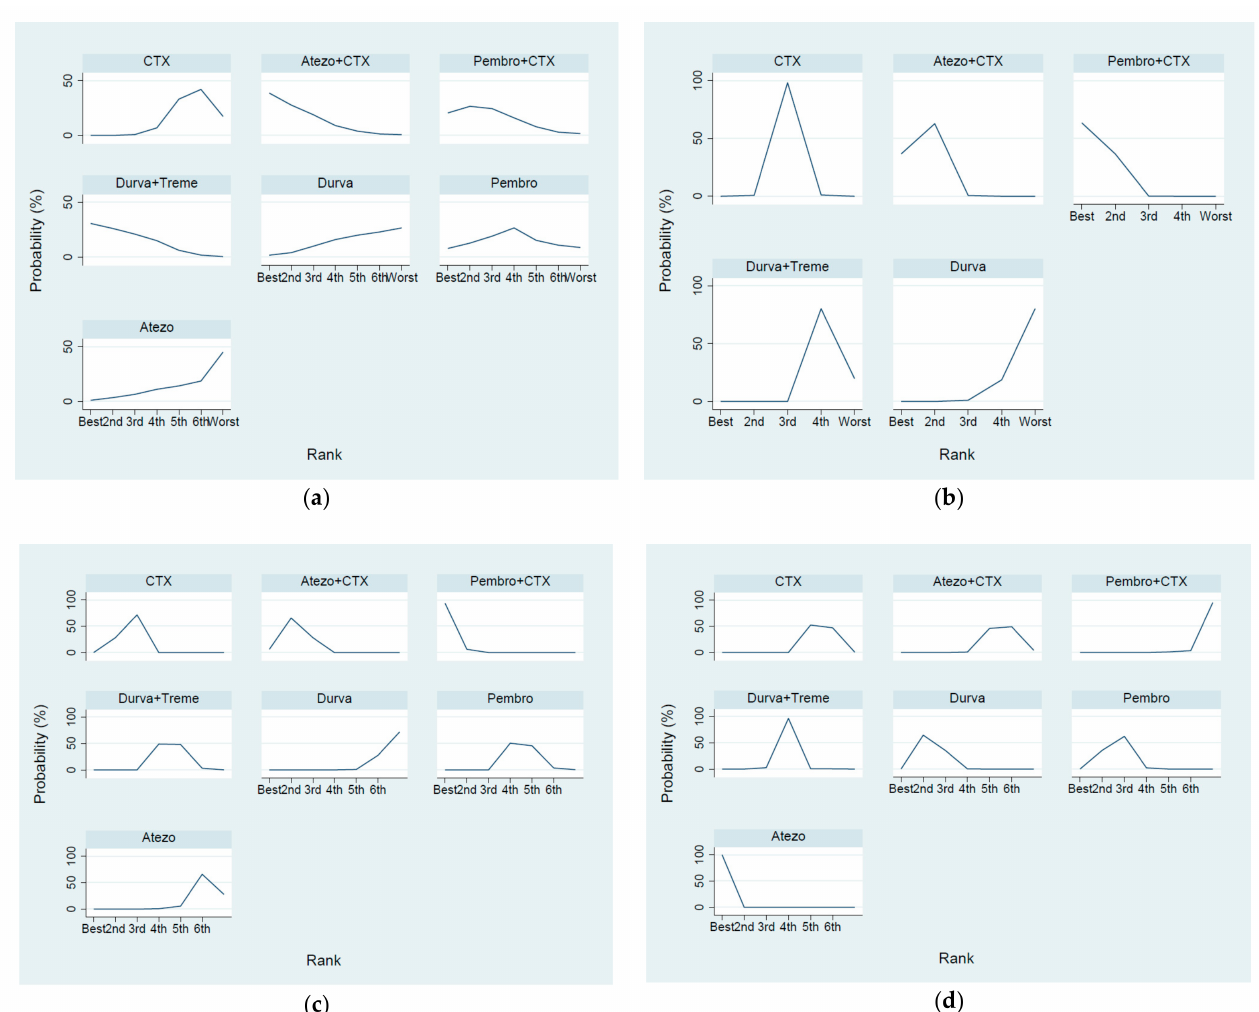
Figure A2. Probability to be best treatment for OS, PFS, ORR, and grade 3–5 AEs. ( a ) Overall survival (HR); ( b ) progression free survival (HR); ( c ) overall response rate; ( d ) risk ratio for grade 3–5